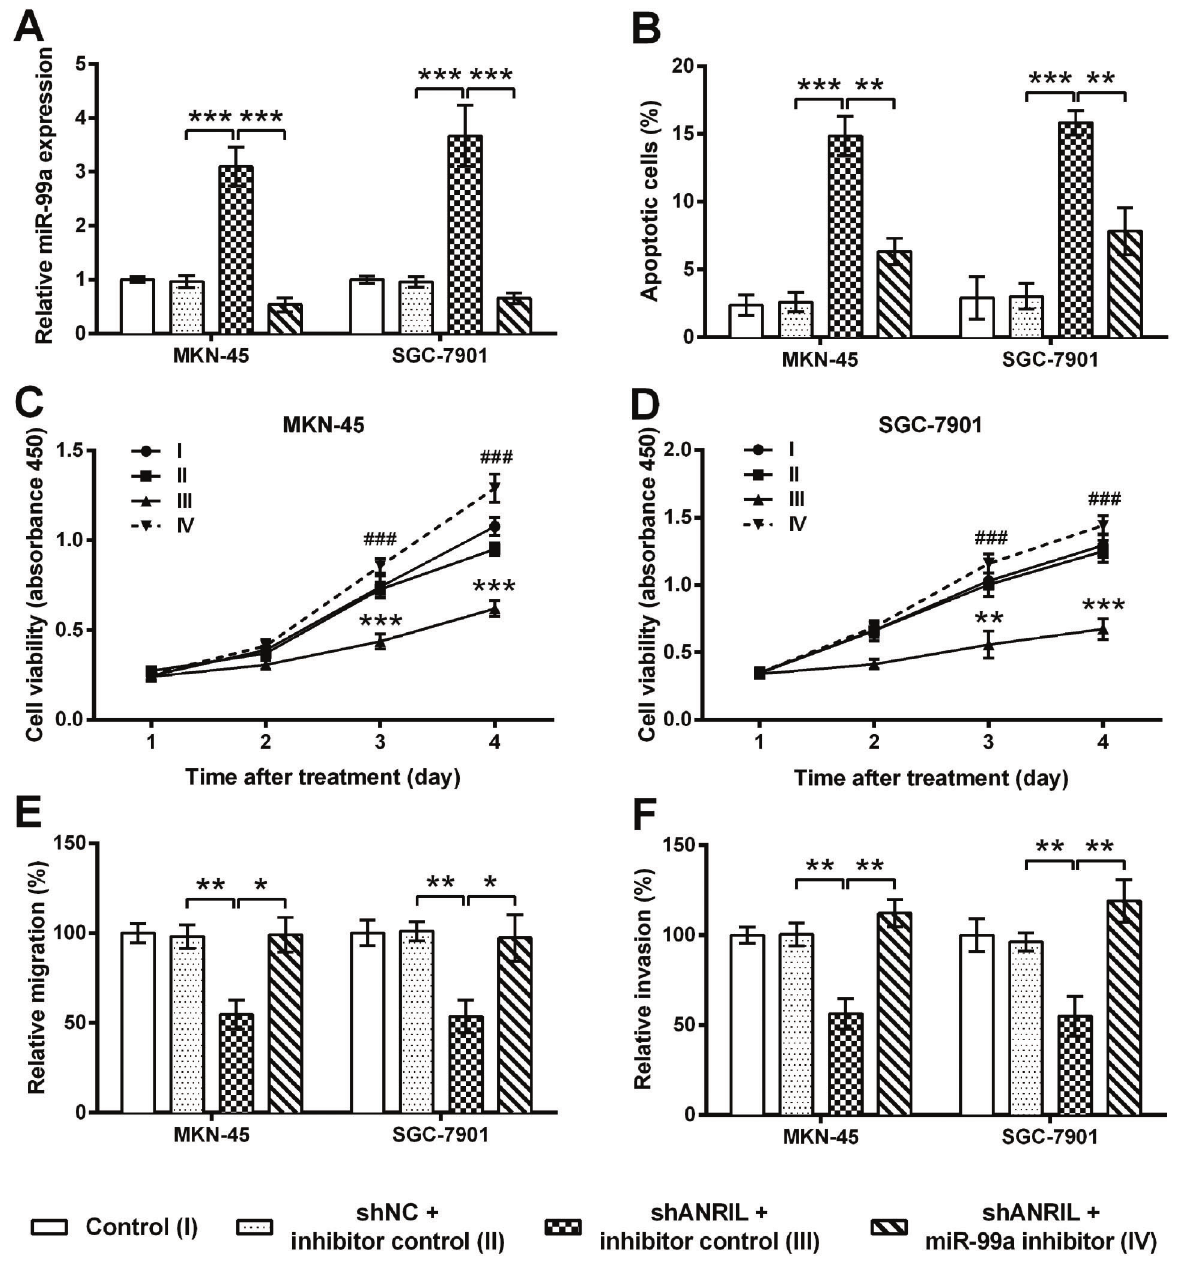
Figure 4. Increase of cell apoptosis and decreases of cell viability, migration, and invasion induced by knockdown of antisense non- coding RNA in the INK4 locus (ANRIL), were reversed by miR-99a inhibition. Non-treated cells acted as control. A , Expression level of miR-99a measured by qPCR. U6 acted as an internal control. B , Rate of apoptotic cells by fl ow cytometry. C and D , Cell viability was determined by CCK-8 assay. The migration ( E ) and invasion ( F ) were measured by Transwell assay. shANRIL: pENTR TM /U6 vector carrying small hairpin RNA targeting ANRIL; shNC: pENTR TM /U6 vector carrying a non-targeting sequence; qPCR: quantitative real- time PCR; CCK-8: Cell Counting Kit-8; miR-99a: microRNA-99a; Data are reported as means ± SD. *P o 0.05; **P o 0.01; ***P o 0.001; ### P o 0.001 (two-tailed Student ’ s t -test). In panels C and D , *indicates signi fi cant difference between the shNC + inhibitor control group and the shANRIL + inhibitor control group, and # indicates signi fi cant difference between the shANRIL + inhibitor control group and the shANRIL + miR-99a inhibitor